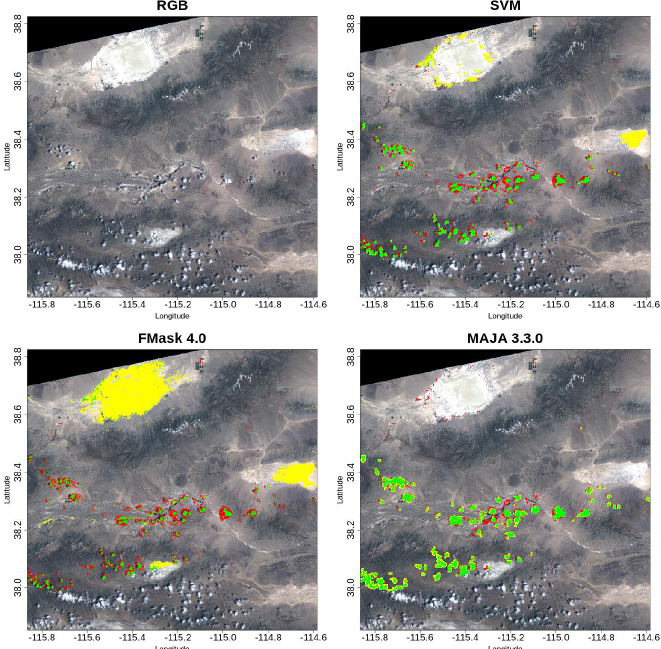
Figure 7. The top left image shows the RGB image from Railroad Valley, Nevada on 1 May 2017. The three other images show the comparison of each procedure (as default) to the reference mask (top-right, SVM, bottom-left, FMask, and bottom-right, MAJA). Green colour corresponds to true positive, red colour to false negative, and yellow to false